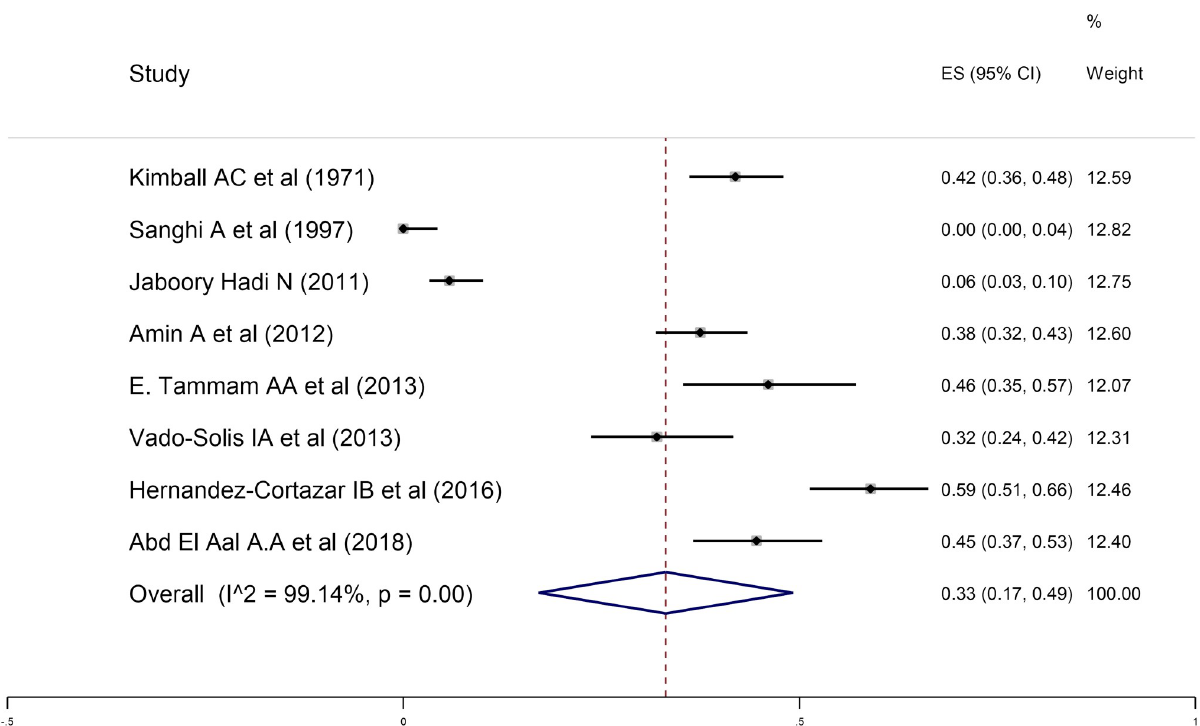
Fig 3. The reported seroprevalence of anti- T . gondii IgG antibody in women who had abortion in present pregnancy.